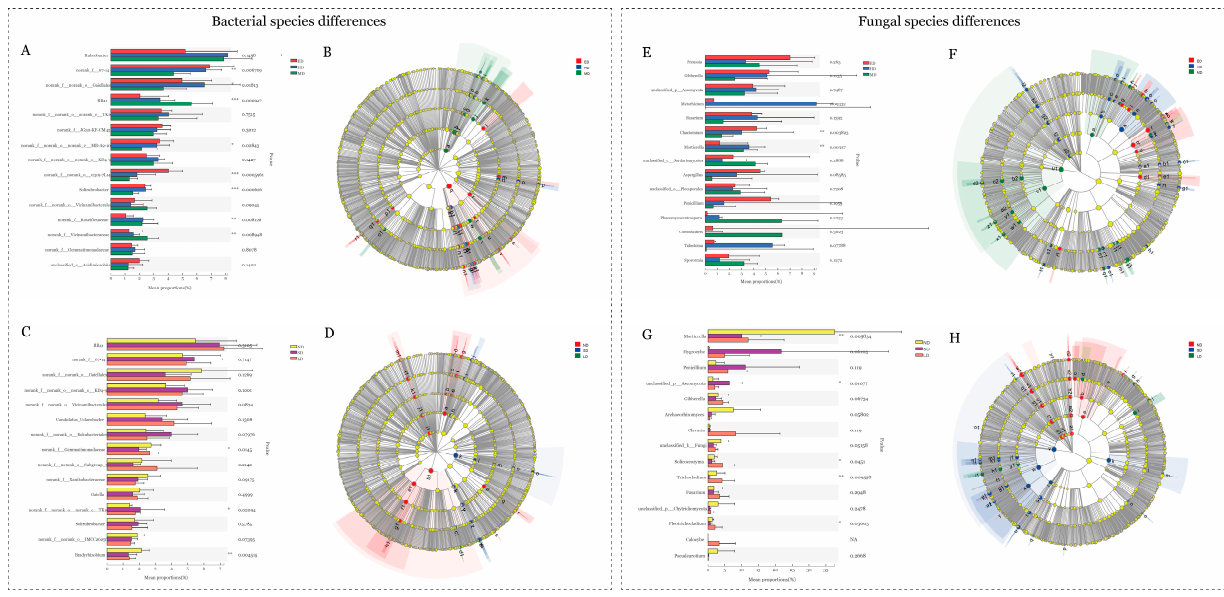
Figure 3. Difference significance test and linear discriminant analysis effect size (LEfSe) of the microbial communities at the genus level. Shown is the analysis of difference significance test of the bacterial ( A ) and fungal ( E ) communities between ED, HD and MD sites and that of the bacterial ( C ) and fungal ( G ) communities between ND, SD and LD (one-way ANOVA was used to check whether the mean value of samples in each group were the same, and fdr was used as multiple test correction method for p value; * p < 0.05, ** p < 0.01, *** p < 0.001). LEfSe of the bacterial ( B ) and fungal ( F ) communities between ED, HD and MD sites and that of the bacterial ( D ) and fungal ( H ) communities between ND, SD and LD with an LDA score higher than 3.5 and p values less than 0.05. Cladograms indicate that the phylogenetic distribution of microbial lineages are associated with the vegetation type. Circles represent phylogenetic levels from phylum to